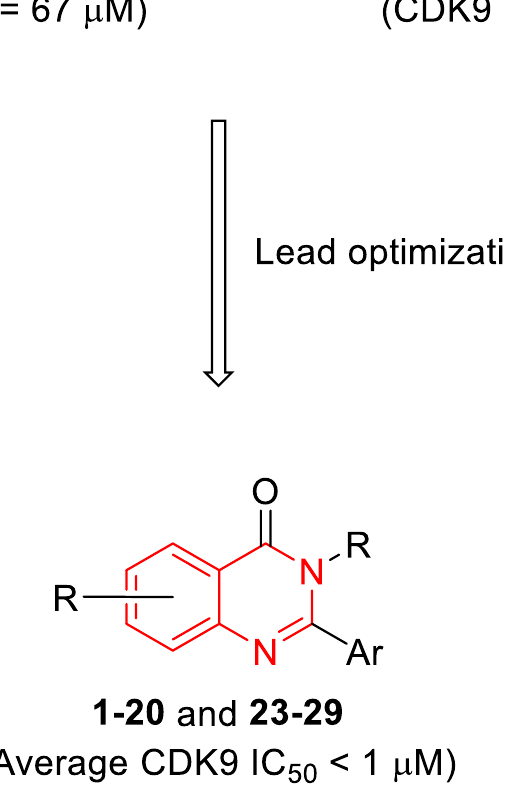
Figure 2 . Rational design of quinazoline derivatives as CDK9 inhibitors ( 1 – 20 and 23 – 29 ).